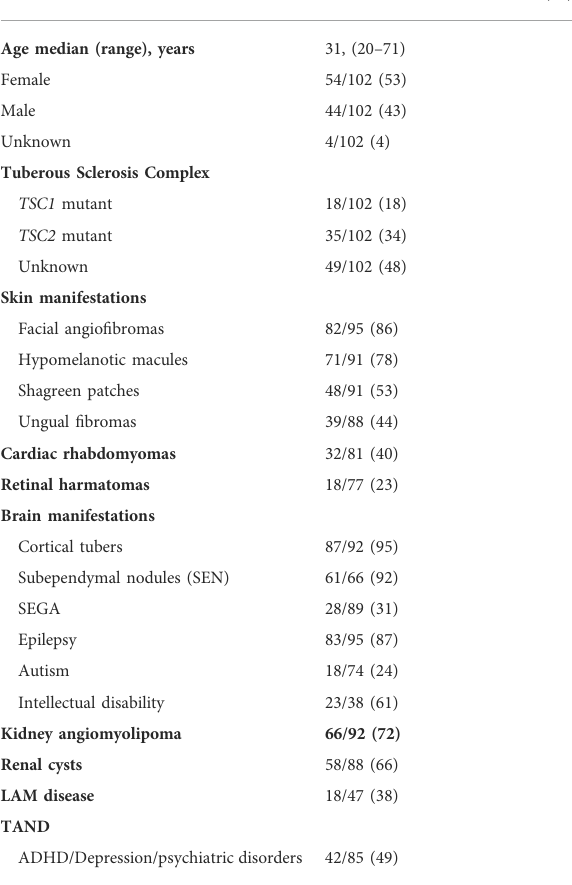
TABLE 1 Summary of clinical data associated with buccal swab samples. Clinical